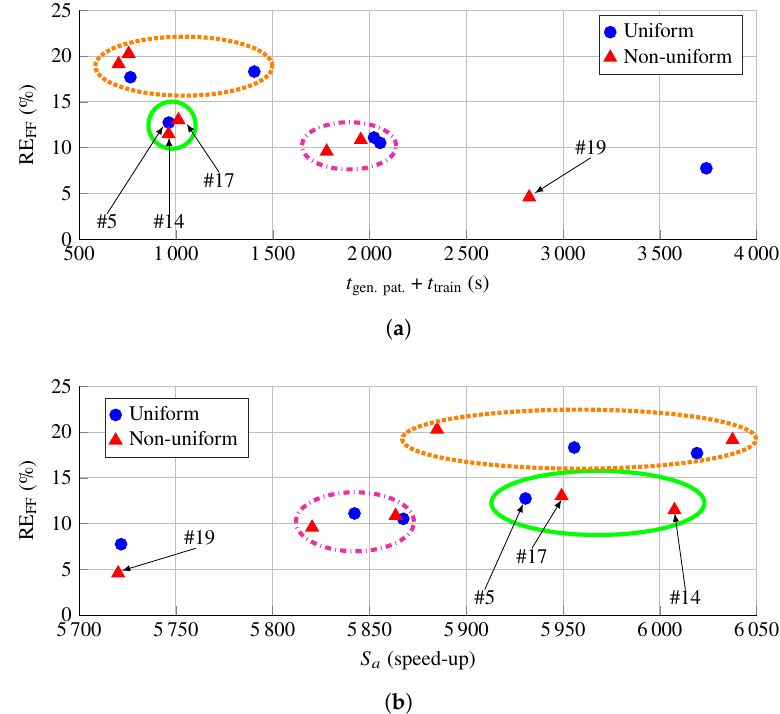
Figure 6. Relative error of the crosspolar pattern for the discretizations of the angles of incidence shown in Table 2 versus: ( a ) the training time, t train , with the time it takes to generate the training patterns, t gen. pat ; and ( b ) the analysis speed-up. Times were measured in parallel mode. The same cluster of points as in Figure 5 are kept here for easy